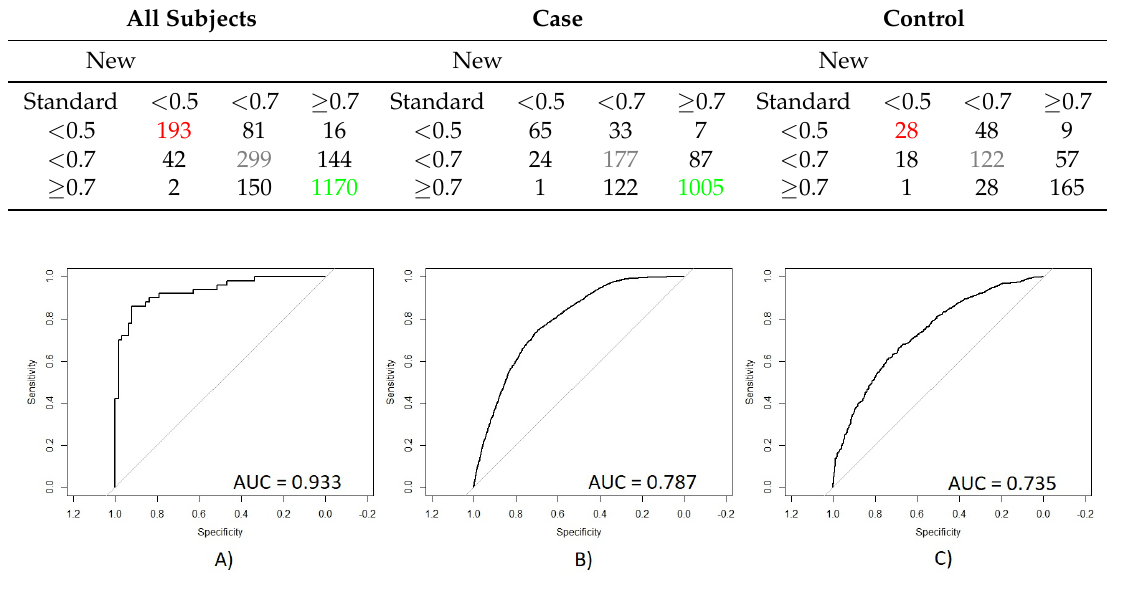
Figure 6. Receiver operating characteristic (ROC) curves of the generated multivariate models for the detection of caries. The horizontal axis represents the 1-specificity measure and the vertical axis represents the sensitivity measure. ( A ) Age group 2, ( B ) Age group 3, ( C ) Age group 4. AUC: area under the